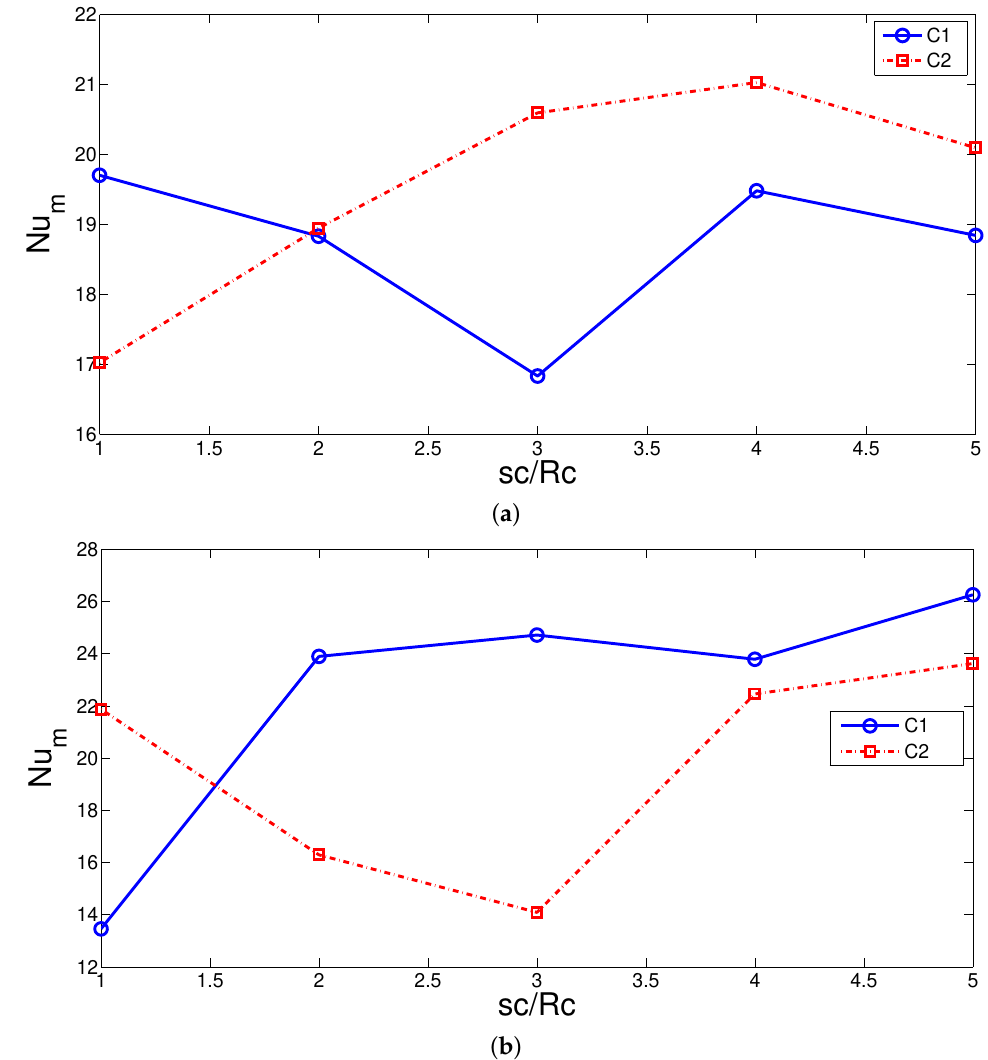
Figure 9. Average Nu variations with varying distances between the hot cylinders for hot cylinder C1 and C2 at two different Rew (Re = 300, Da = 0.01, HNF-2%). ( a ) Rew = 0; ( b ) Rew = −